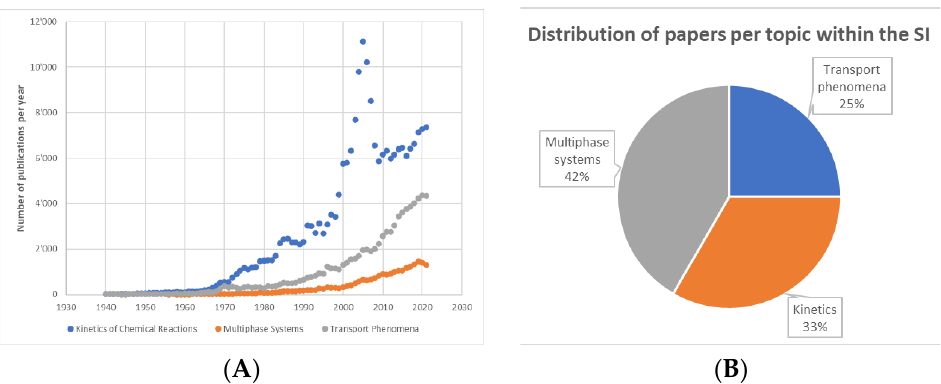
Figure 1. Statistical information related to the Special Issue “Industrial Chemistry Reactions: Kinetics, Mass Transfer and Industrial Reactor Design”. ( A ) Number of publications per year related to each specific macro area (Scopus Database). ( B ) Distribution of papers per macro area.